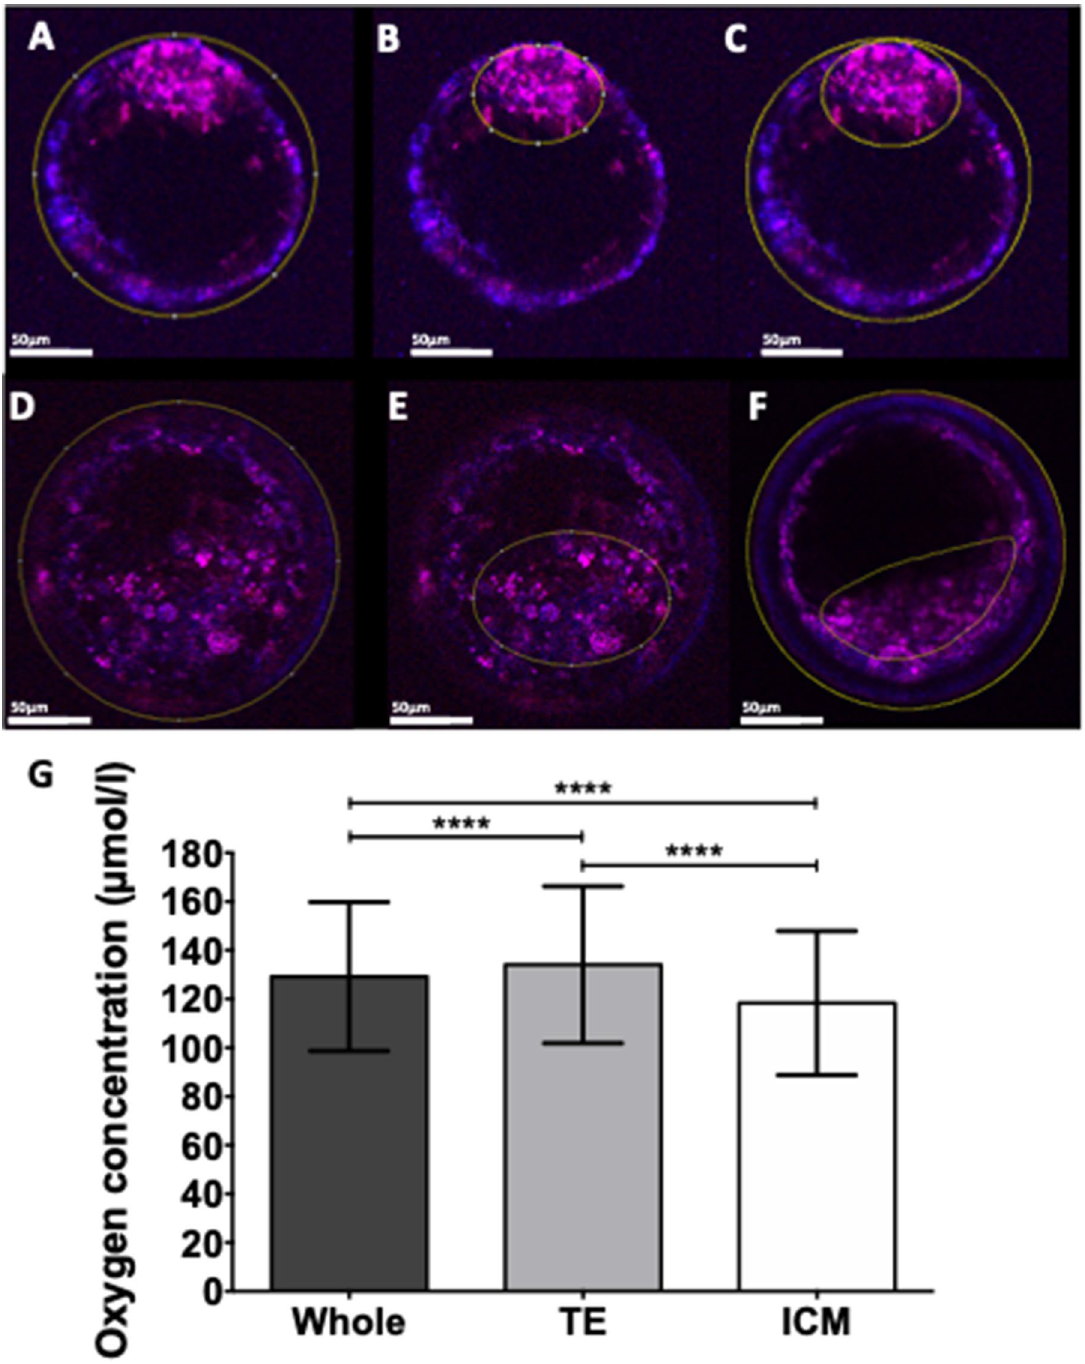
Figure 4. Blastocyst ICM and TE icO 2 . ( A – F ) Example of using ImageJ region of interest selection to measure relative signal intensity of ( A , D ) Whole blastocyst, ( B , E ) Inner Cell Mass (ICM) and ( C , F ) Trophectoderm (TE) regions. Merged images are shown; channels were measured individually. ( G ) Quantitative comparison of change in icO 2 between whole blastocyst(129.23 ± 30.54 µmol/l), TE (134.10 ± 32.18 µmol/l) and ICM (118.33 ± 29.57 µmol/l, n = 82). Values plotted as mean ± SD for the number of analyses shown ****p <